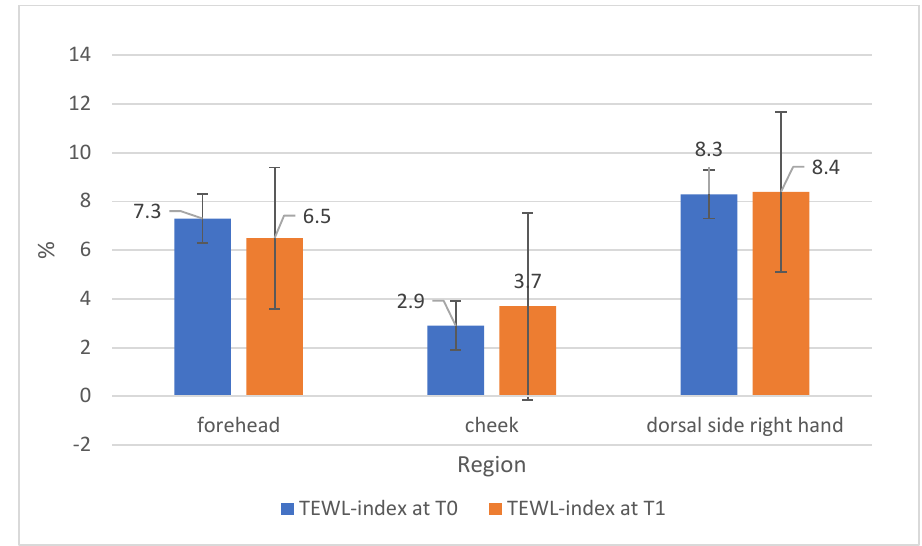
Figure 6. TEWL index values of the professional dancers at time points T0 and T1; n = 29.